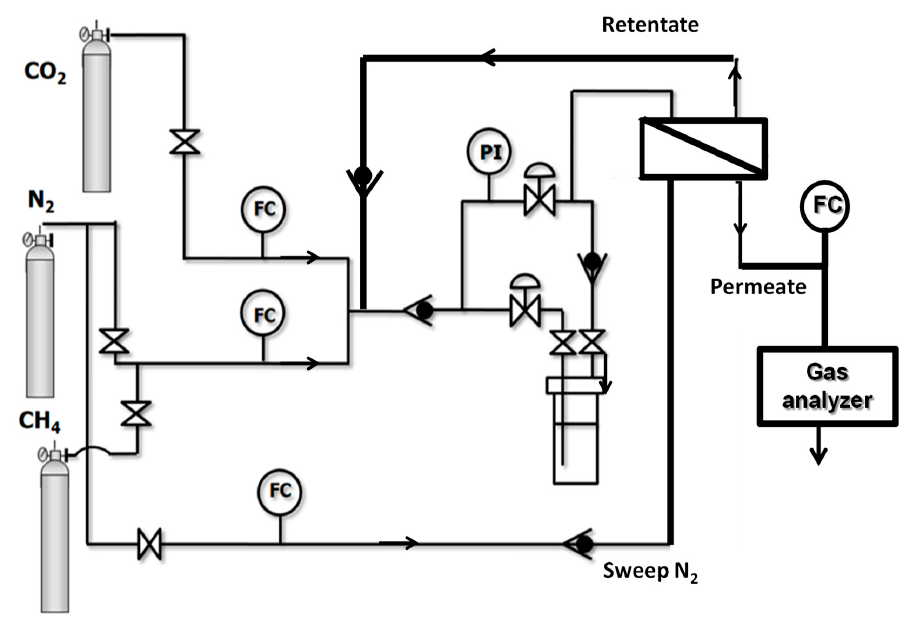
Figure 1. Diagram of the gas separation plant used in the experiments.